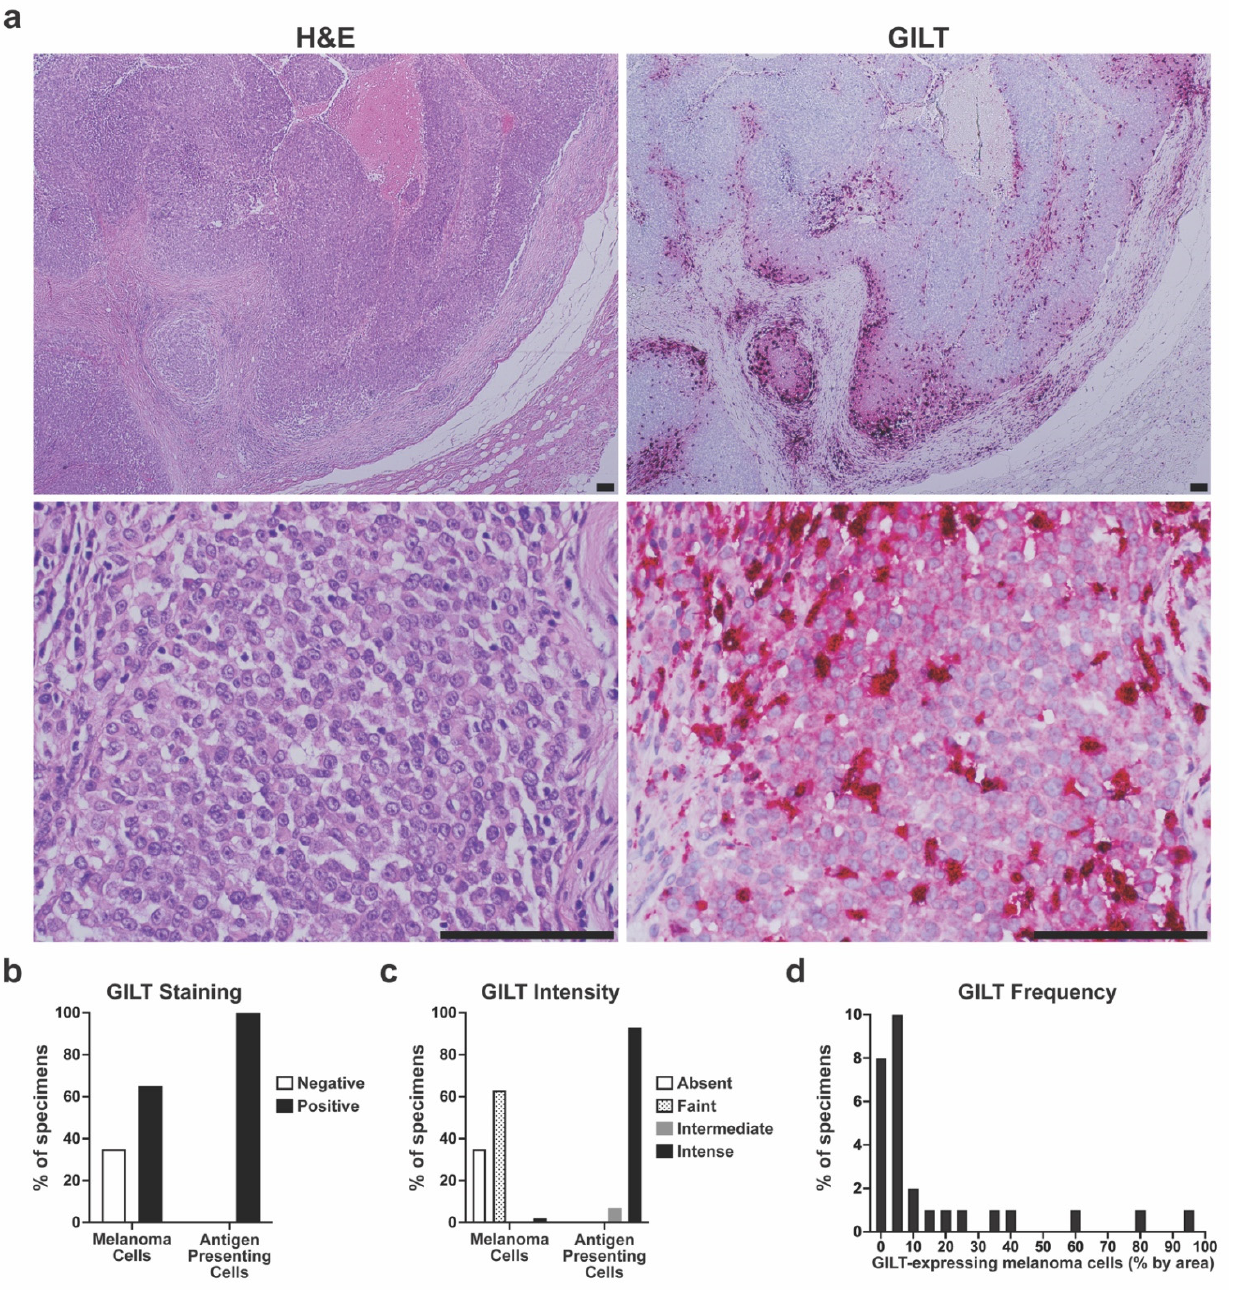
melanoma is associated with improved overall survival in metastatic melanoma patients treated with ICI.